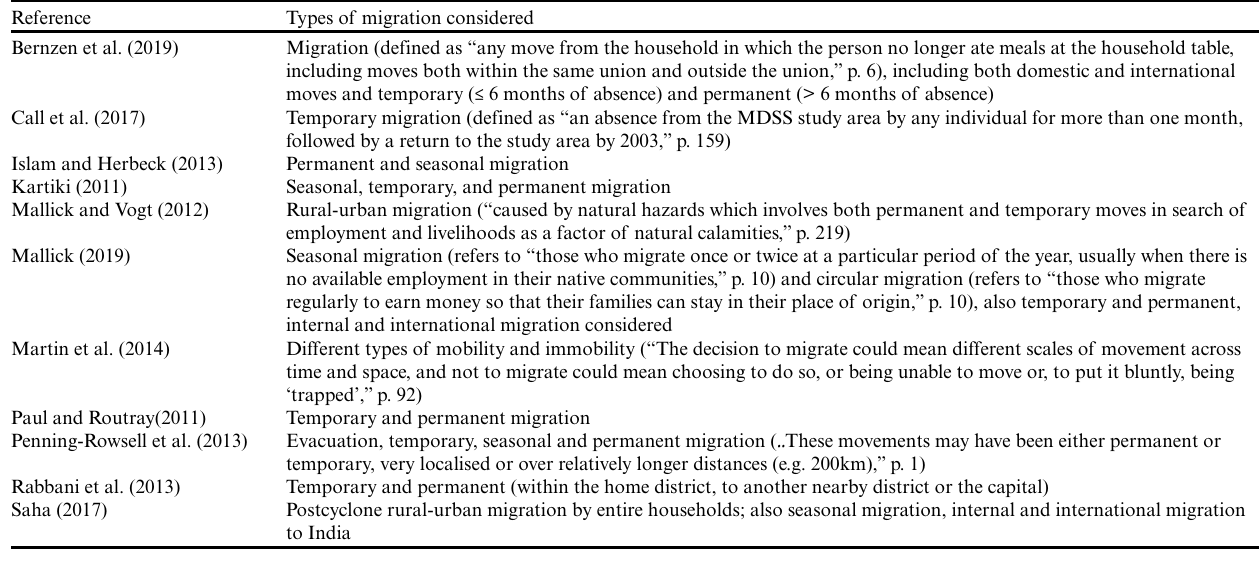
Table 1 . Selected case studies from coastal Bangladesh and the respective types of migration considered in each study.